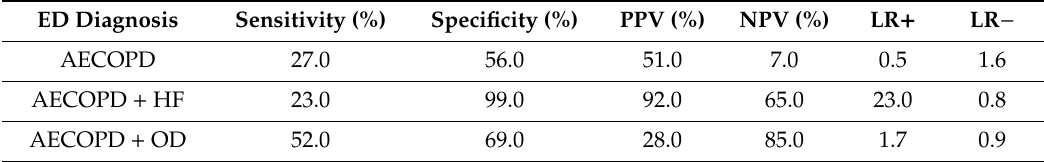
Table 2. Diagnostic accuracy of ED diagnosis in relation to RW diagnosis.